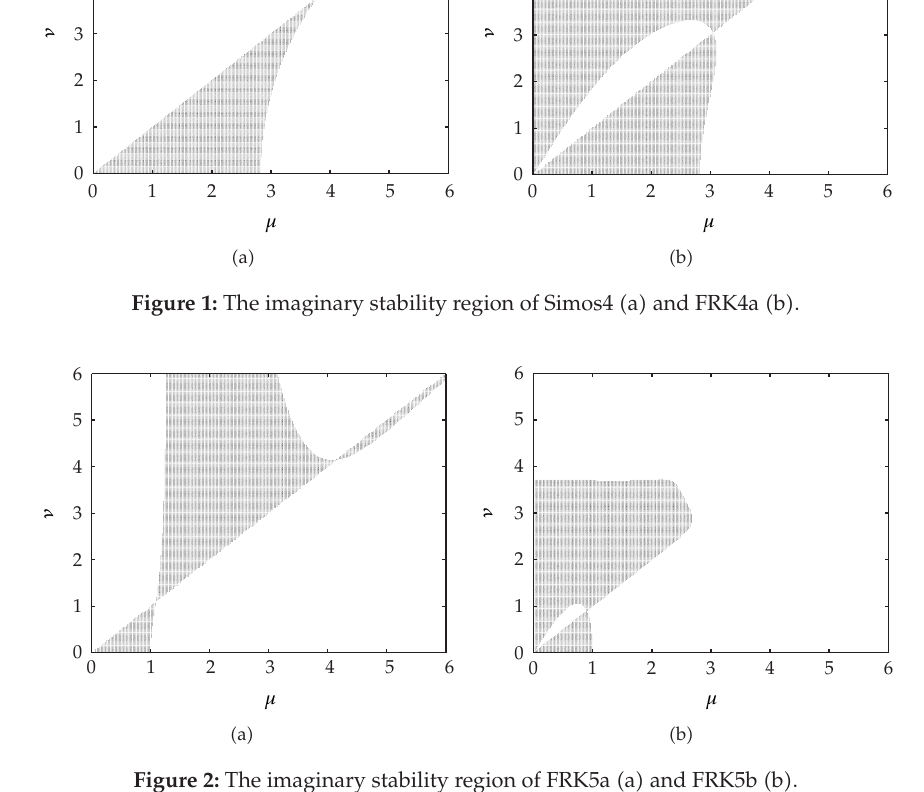
Figure 2: The imaginary stability region of FRK5a (cid:3) a (cid:4) and FRK5b (cid:3) b (cid:4)